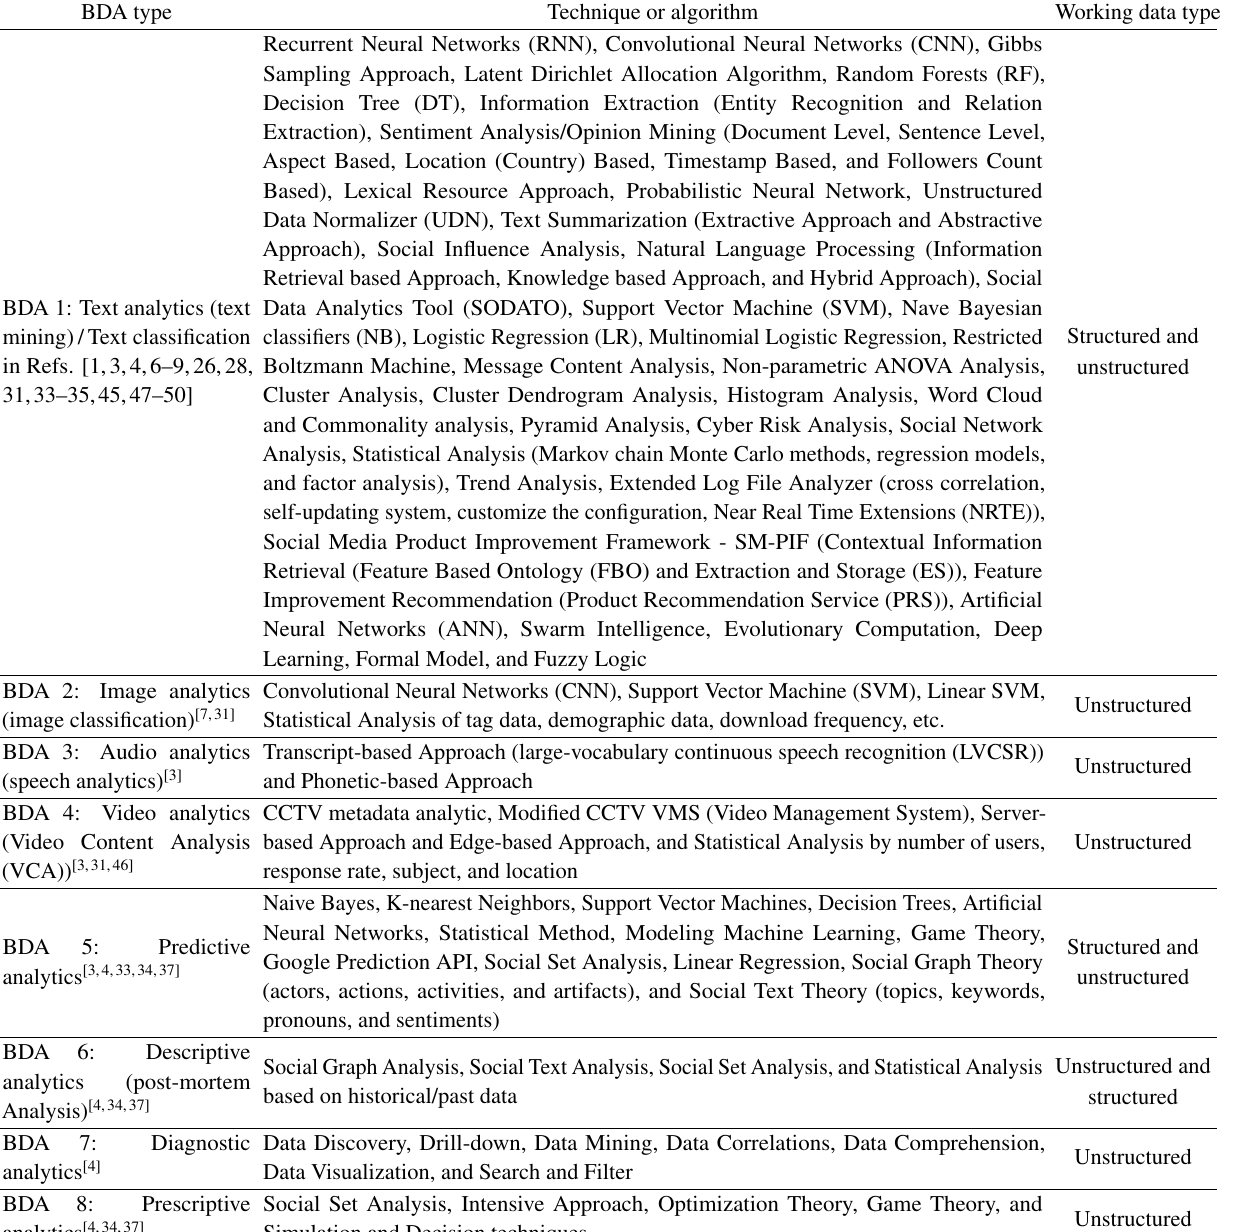
Table 7 Techniques used in each of social media big data